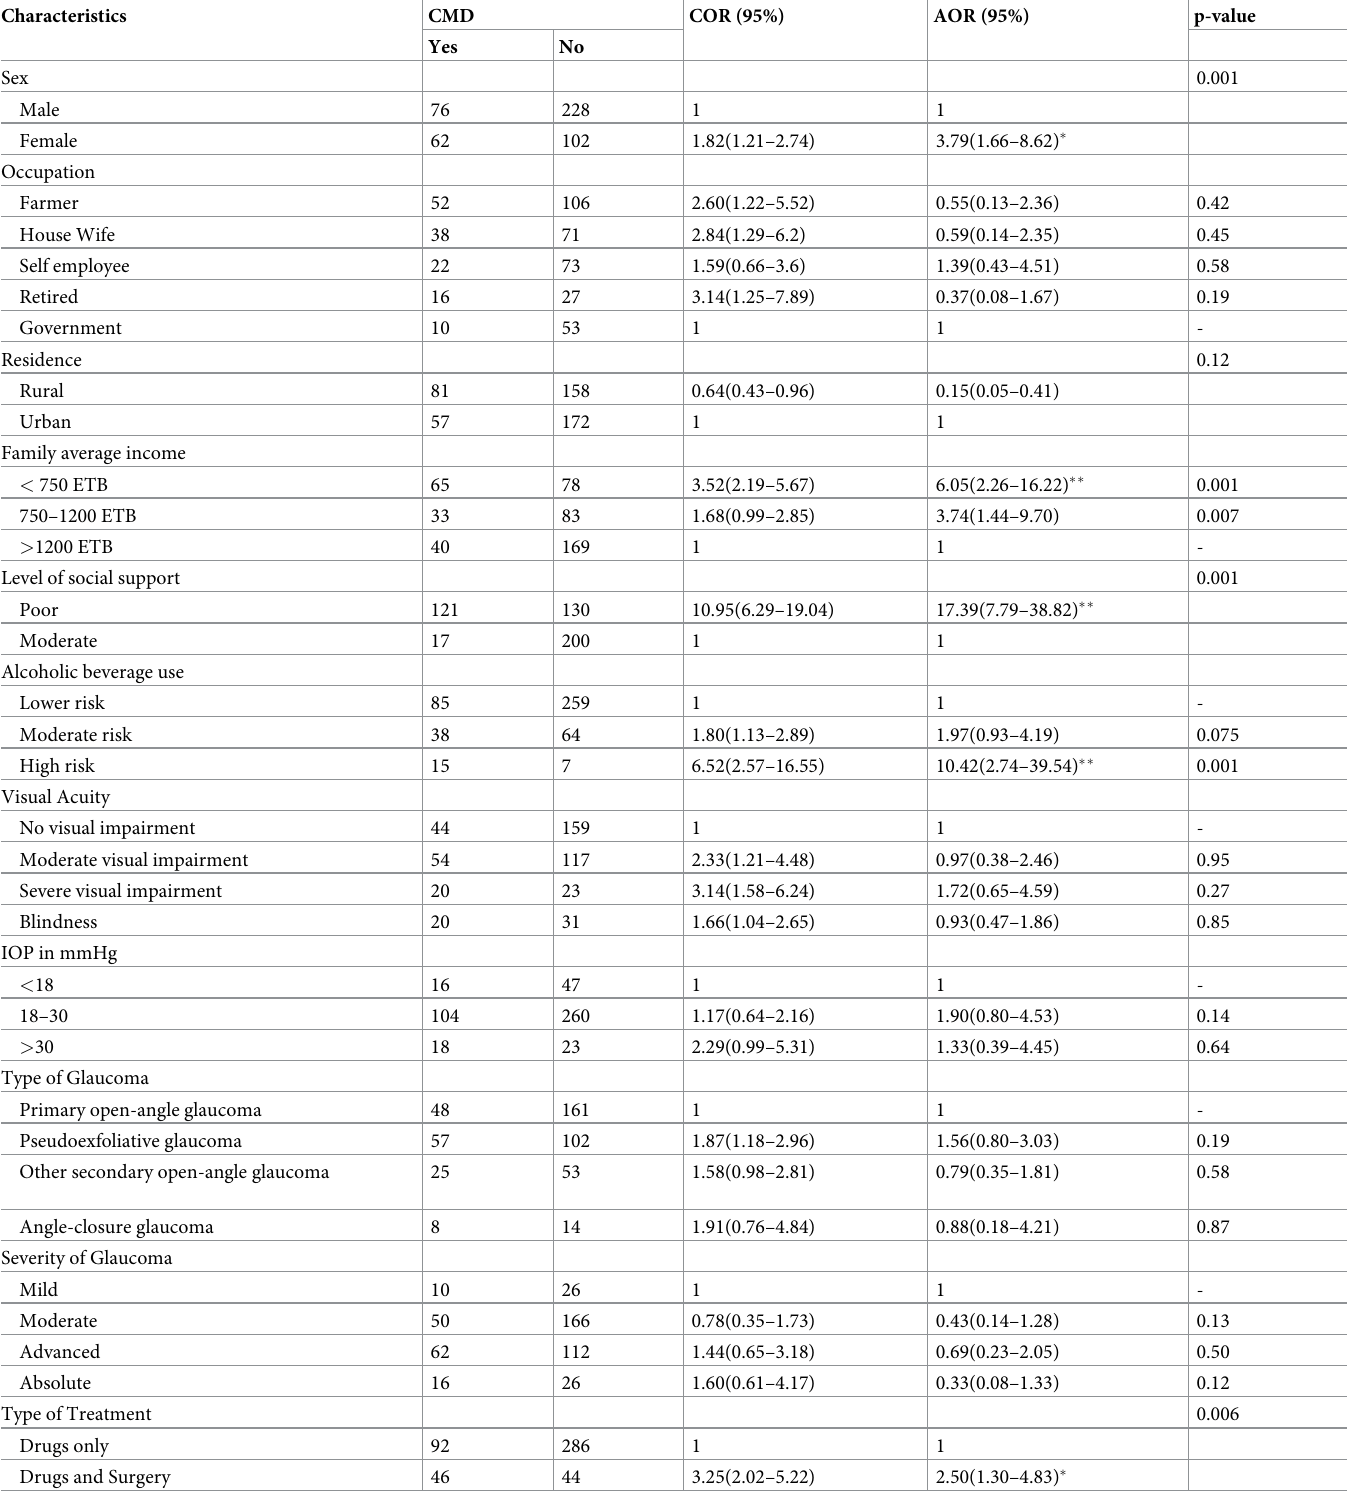
Table 5. Factors associated with common mental disorders among study participants.